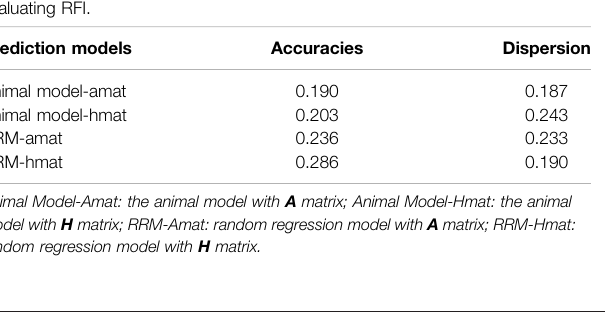
TABLE 3| Theprediction accuraciesand dispersion (|1-b|) offour kindsofmodels evaluating RFI. Prediction models